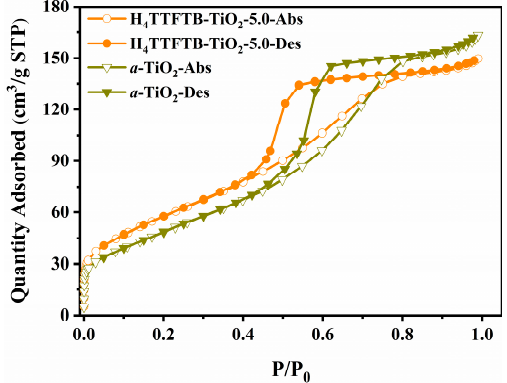
Figure 2. N 2 adsorption-desorption isotherms of H 4 TTFTB-TiO 2 system measured under 77 K.